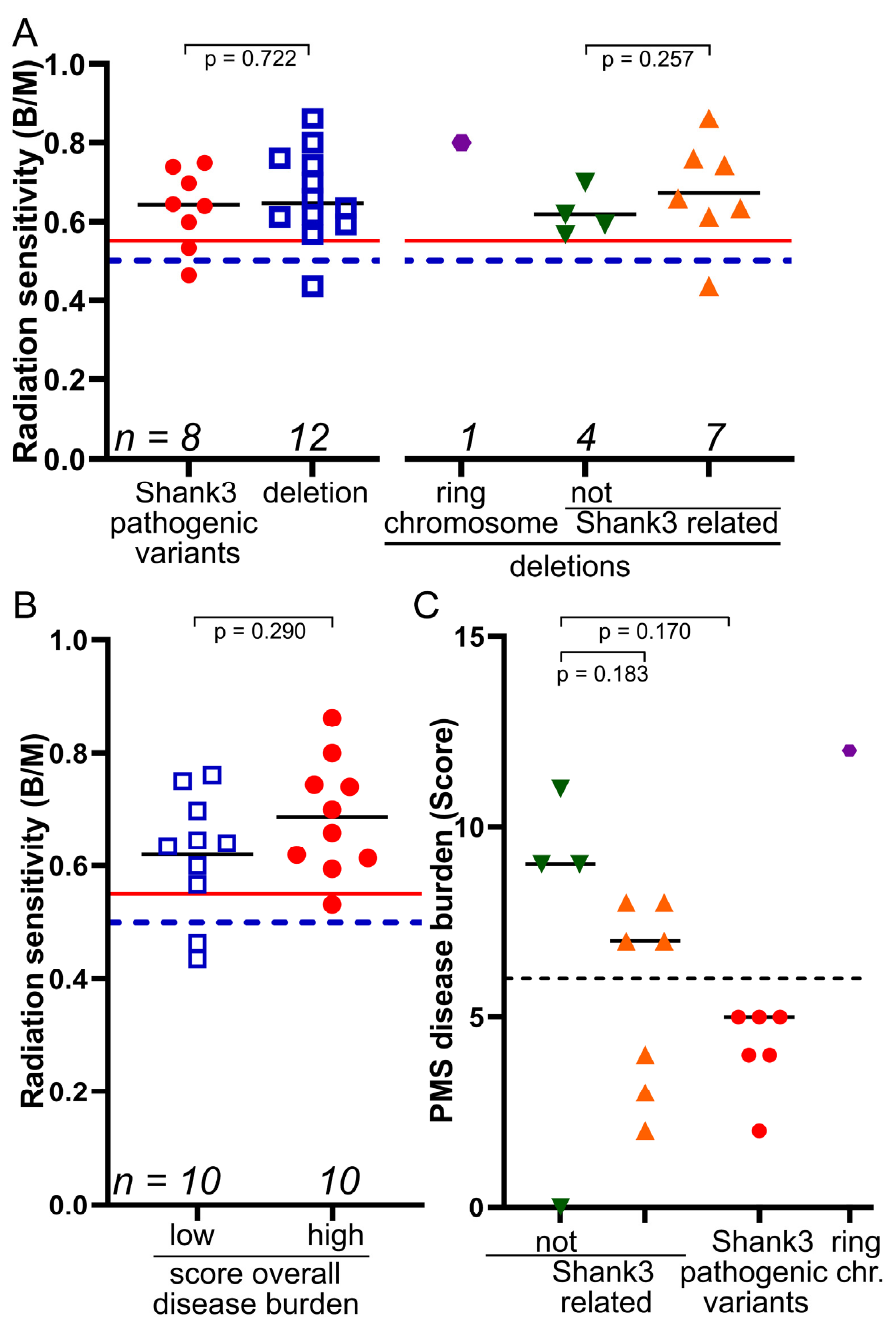
Figure 5. Association of pathogenic variant locations and burden of disease with radiation sensitivity. ( A ) Radiation sensitivity associated with PMS pathogenic variants within the gene compared with deletions in the terminal region of chromosome 22q, including the ring chromosome and ring chromosome compared with deletions, not including SHANK3. ( B ) A score of 14 points for the most severe disease burden was formed from all clinical characteristics. The low group had ≤ 6.0 points and the high group had > 6.0 points. ( C ) Pathogenic variants within the SHANK3 gene compared with deletions in the terminal region of chromosome 22q (unrelated or associated with the SHANK3 gene) and their association with a PMS disease burden score. B/M = Breaks per metaphase. The dashed blue line indicates individuals with increased radiation sensitivity and the solid red line indicates individuals with significantly increased radiation sensitivity. The dashed black line indicates the median PMS disease burden score. chr. = chromosome.